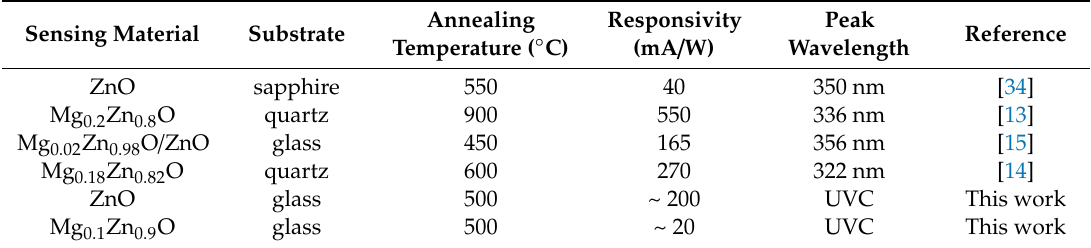
Table 3. Comparison of results of di ff erent sol-gel derived UV photodetectors.